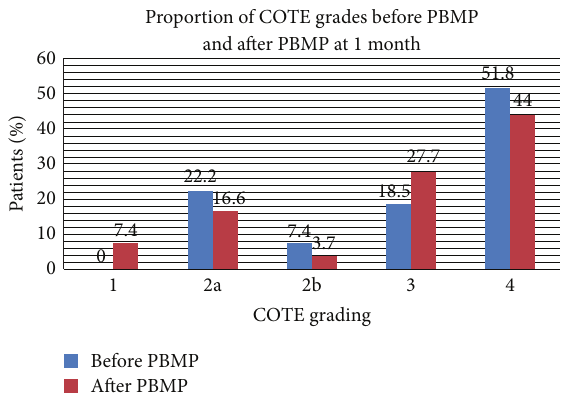
Figure 4: The severity of PB was classified according to COTE